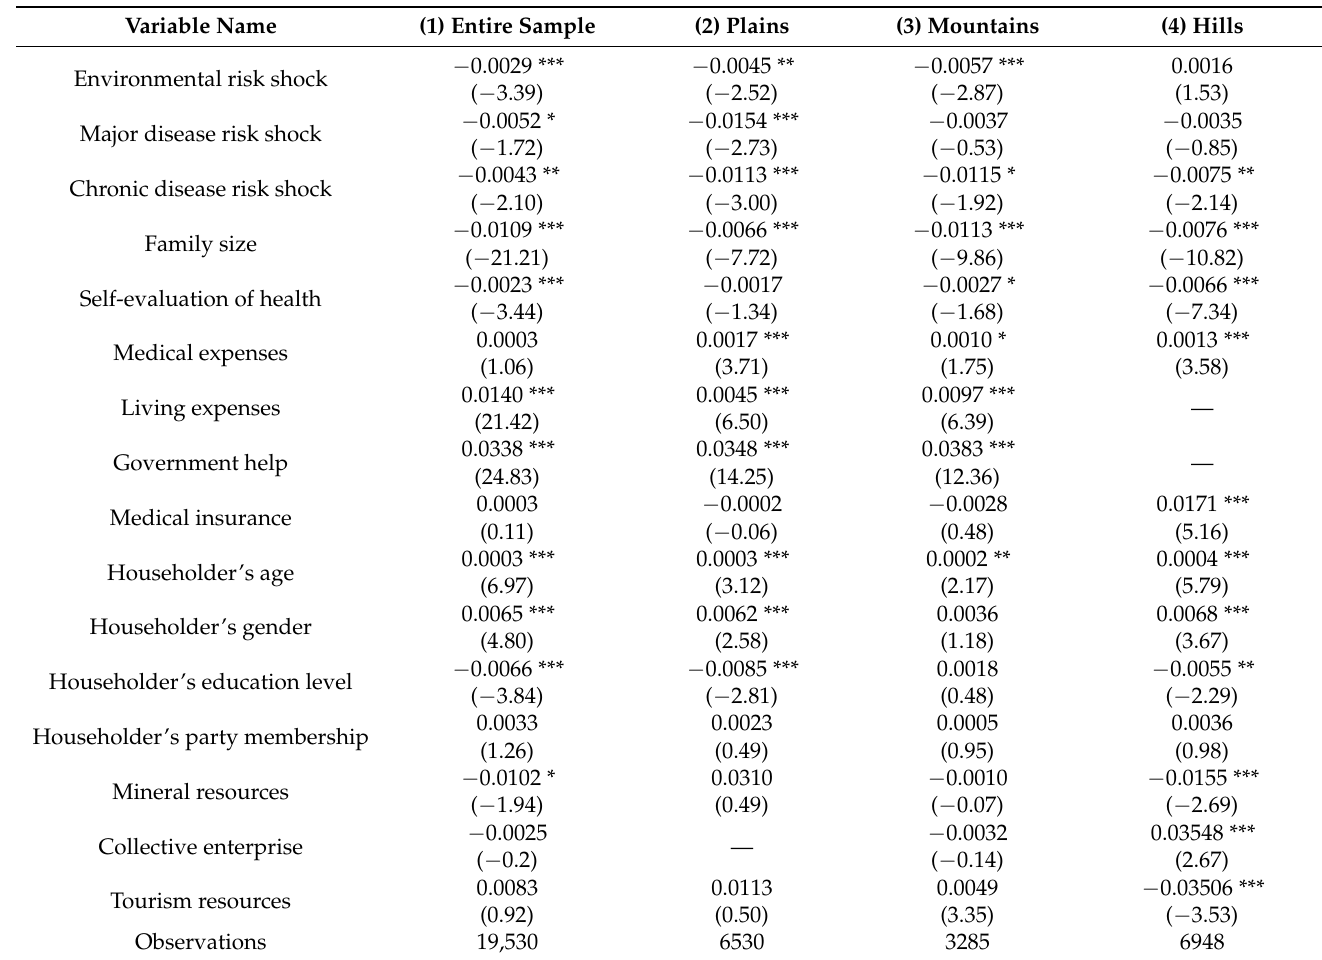
Table 4. Model estimation